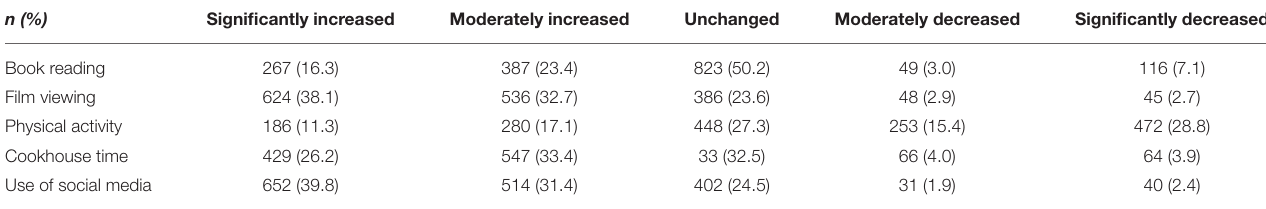
TABLE 4 | Activity changes of the responders during the COVID-19 emergency. n (%)